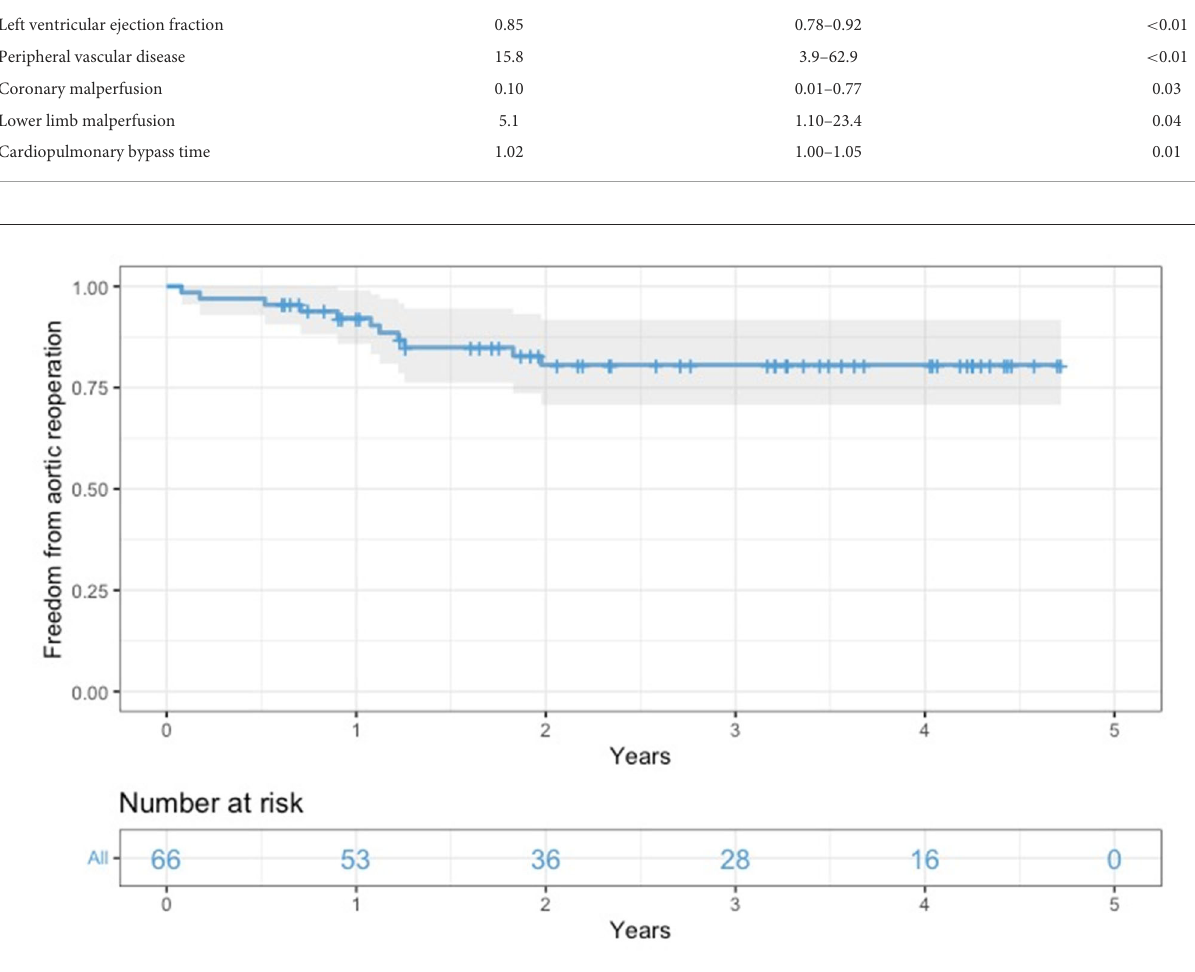
FIGURE4 Kaplan-Meier freedom from aortic reoperations curve for the overall surgical